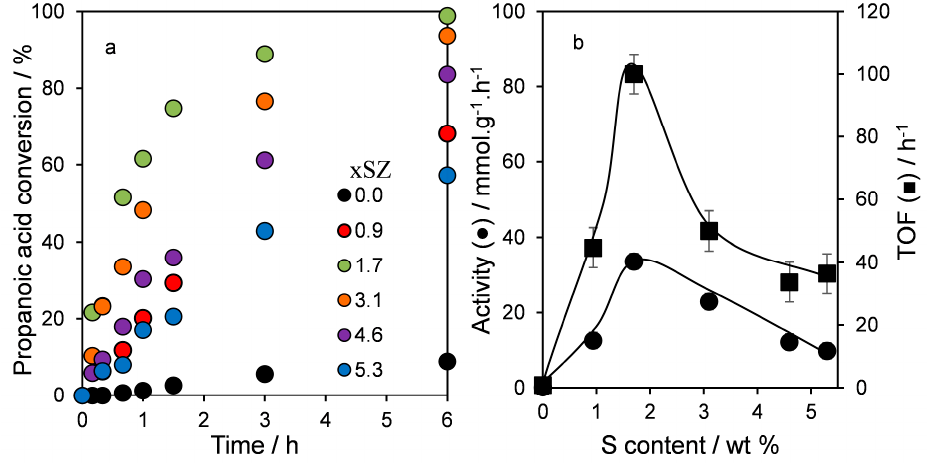
Figure 9. ( a ) Reaction profiles, and ( b ) initial rate and TOF for propanoic acid esterification with methanol over parent and sulfated zirconia catalysts as a function of bulk S loading.